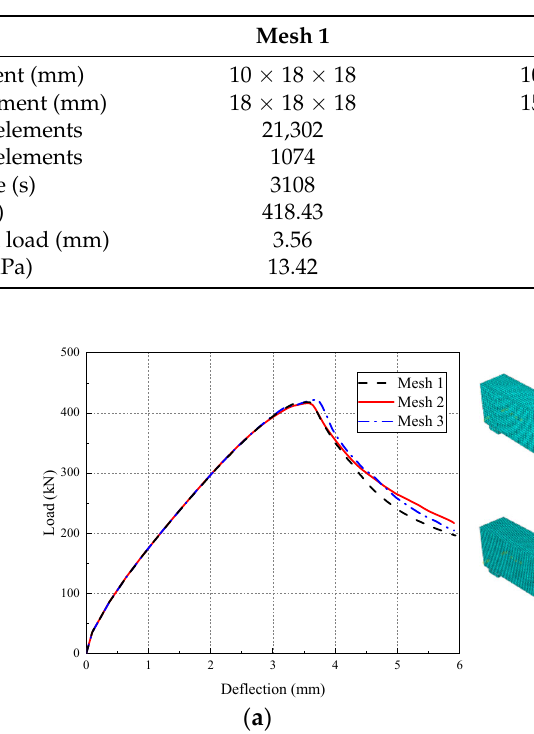
Table 5. Mesh size analysis. Figure 10. Spring constraint schematic diagram.